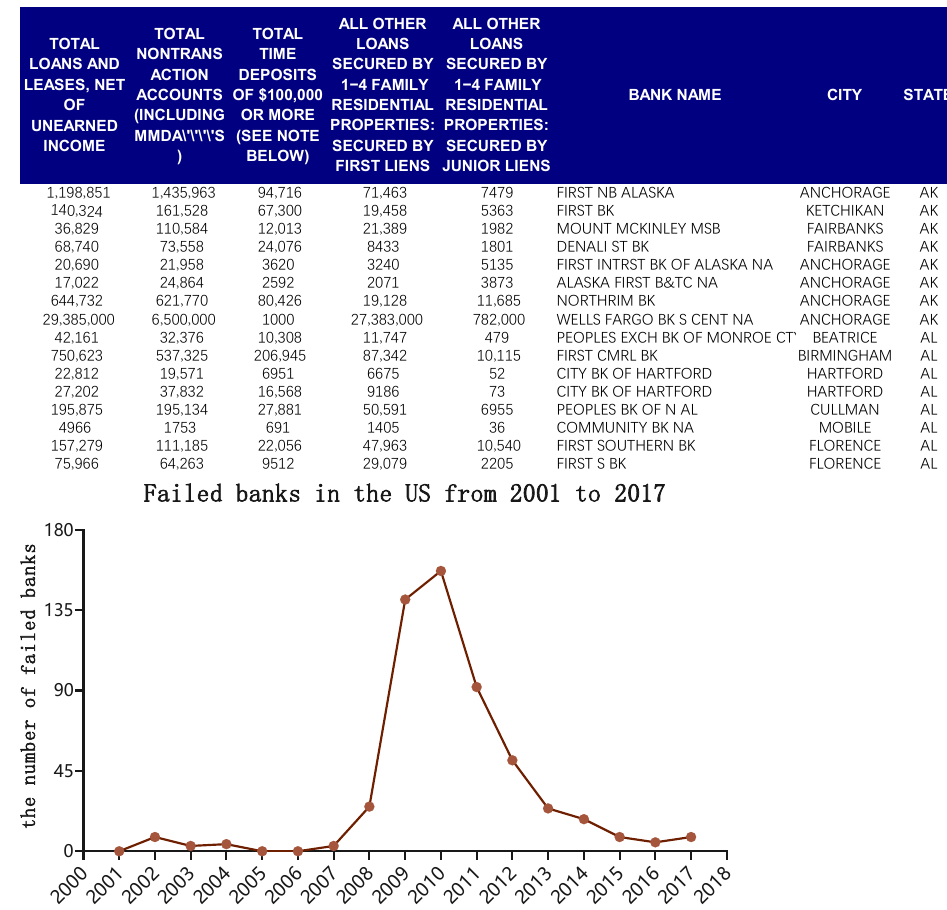
Figure 2. The top panel: the data of the balance sheet. The bottom panel: the number of banks that failed each year from 2001 to